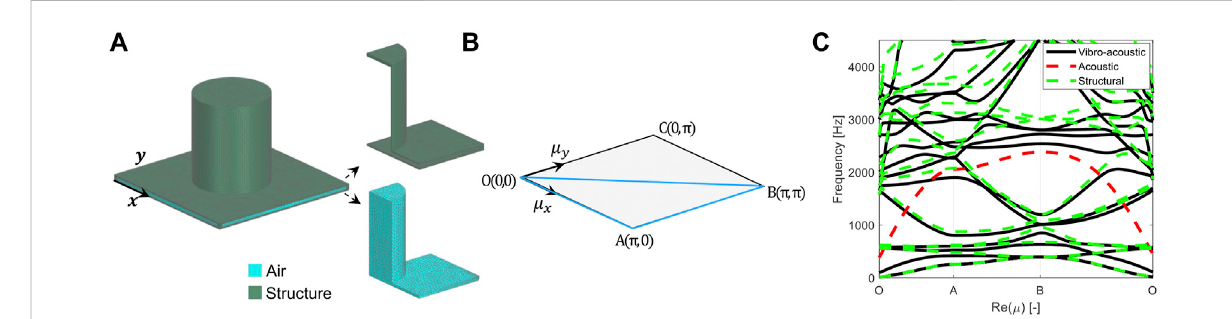
FIGURE 2 (A) FEmodelofthevibro-acoustic2DperiodicUCwithadetailofonefourthoftheacousticandstructuralpart, (B) IBCinreciprocalwavespace,